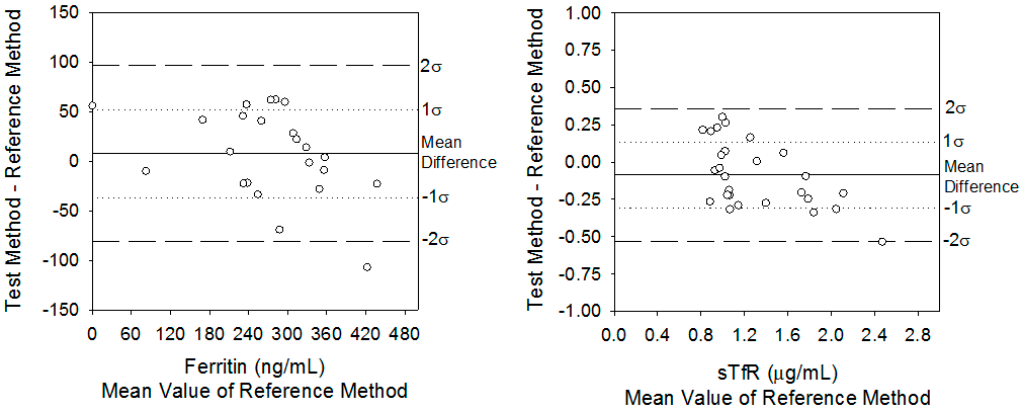
Figure 2. Difference plots comparing serum ferritin and sTfR concentrations from hemodialysis patients using the PC biosensor against the certified ELISAs. using the PC biosensor against the certified